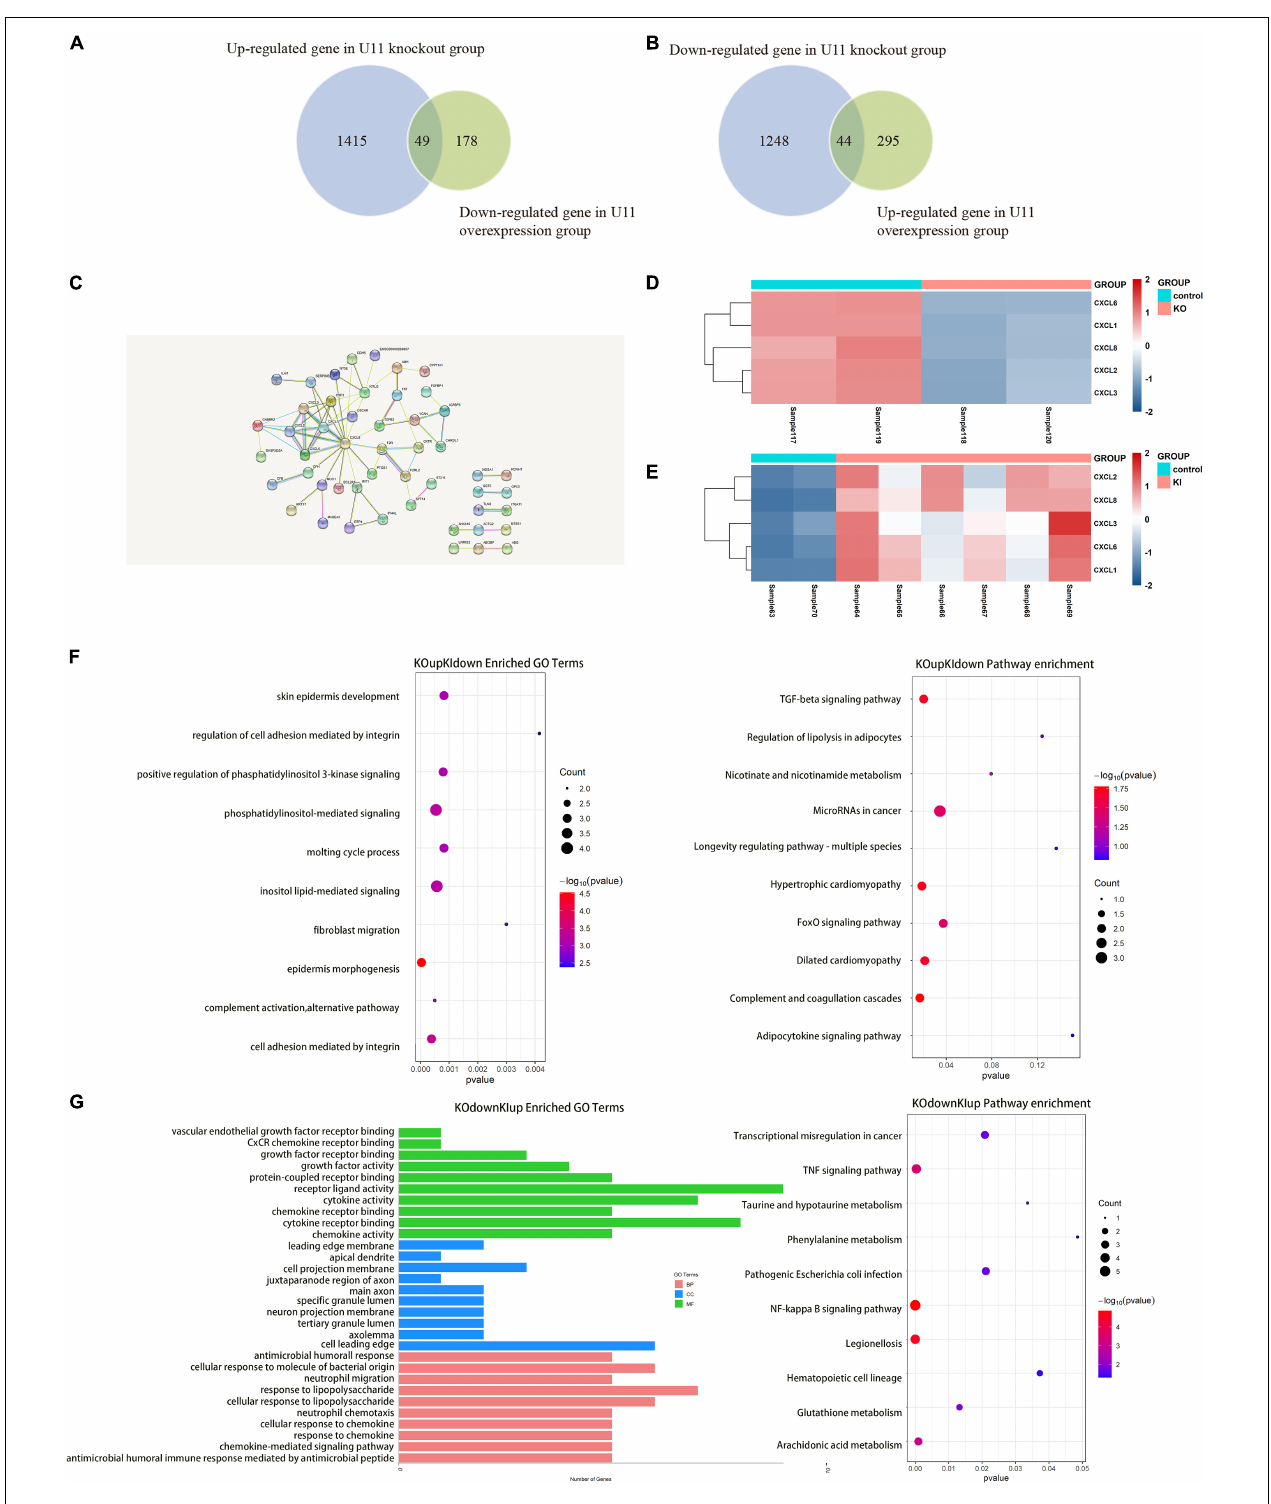
FIGURE 4 | Comprehensive analysis of DEGs upon knocking out and overexpressing U11 in T24 cell lines. (A,B) Venn diagrams of the intersection of differentially expressed genes between U11 overexpression group and knockout group. (C) Protein–protein interactions (PPI) of intersection gene. (D) The heatmap of CXCL family genes in T24 U11 − KO and T24 WT cell lines. (E) The heatmap of CXCL family genes in T24 U11 − KI and T24 WT cell lines. (F) Pathways from intersecting genes of up-regulated genes in T24 U11 − KO cell line and down-regulated genes in T24 U11 − KI cell line. (G) Pathways from intersecting genes of down-regulated genes in T24 WT cell line and up-regulated genes in T24 U11 − KI cell